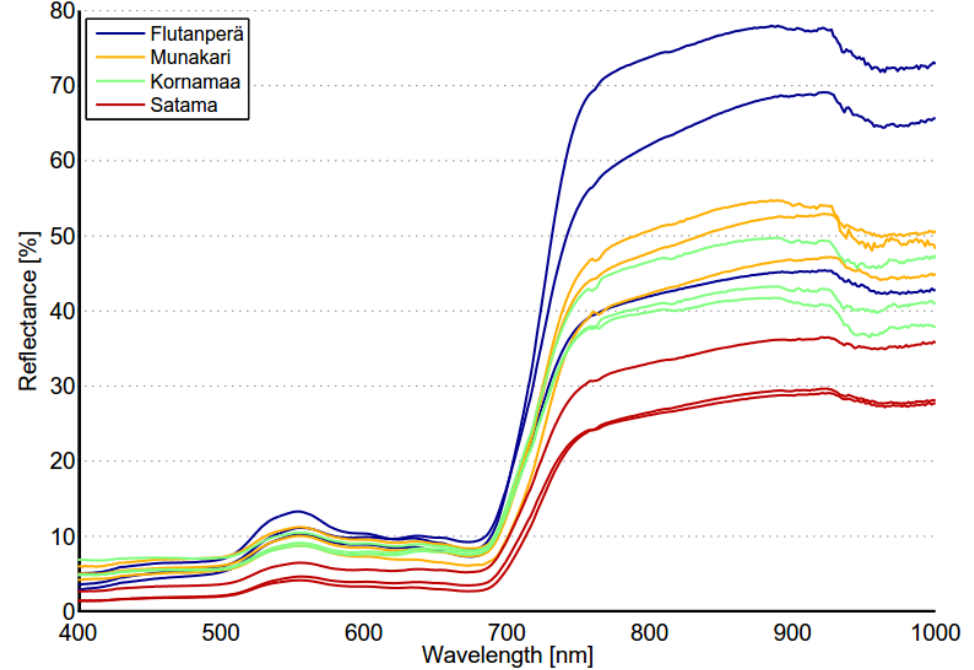
Figure 7. The reed bed reflectance spectra at the four test sites in Olkiluoto Island.